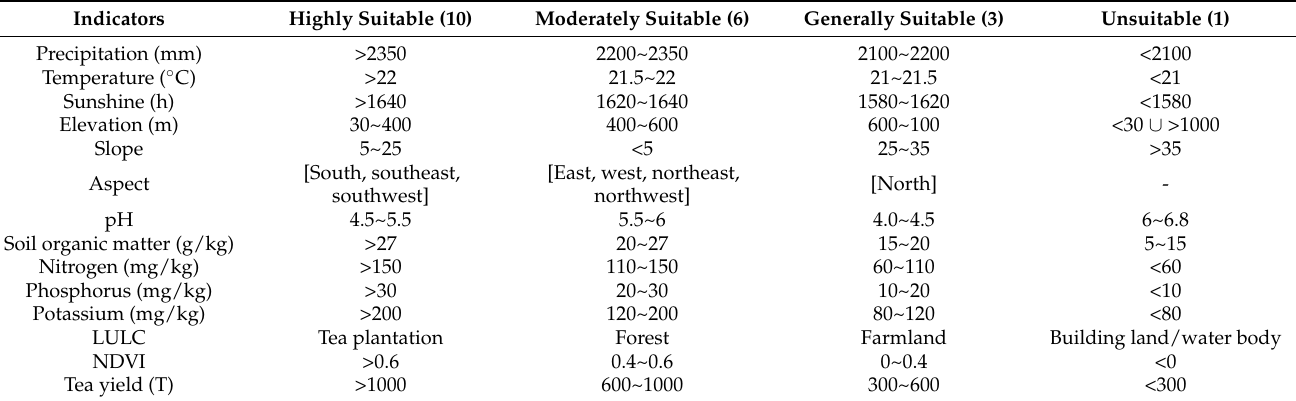
Table 2. Reclassification of the indicators for tea cultivation suitability